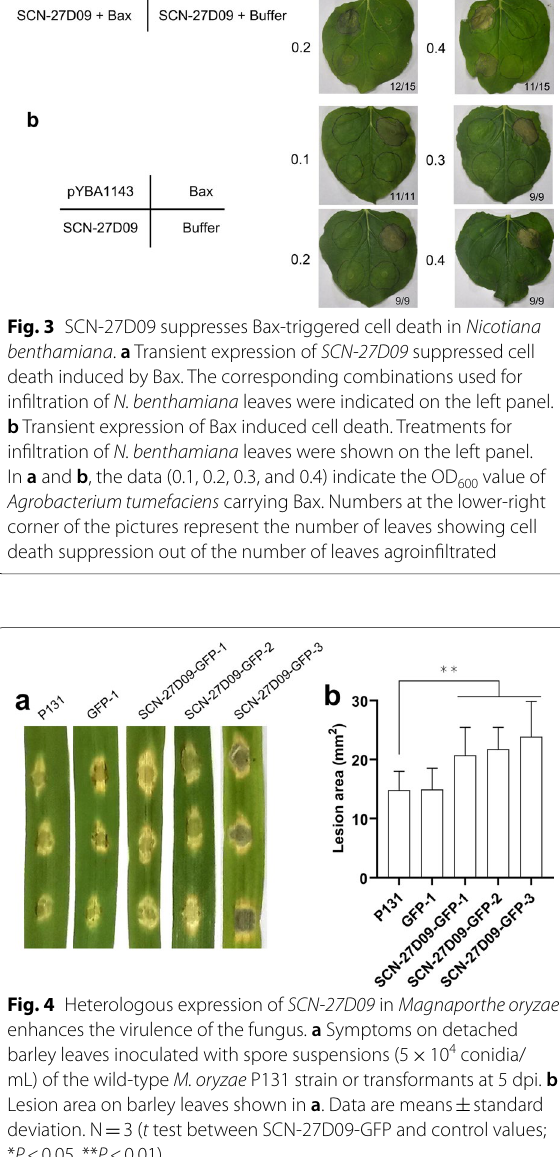
pair, but not in other control pairs including the GFP- NLuc and SCN-27D09-CLuc pair and the GmIPK-2- NLuc and GFP-CLuc pair (Fig. 5b). The luciferase activity of the GmIPK-2-NLuc and SCN-27D09-CLuc pair was also significantly higher than that of the controls (Fig. 5c). Taken together, these results indicated that SCN-27D09 physically interacted with GmIPK-2.